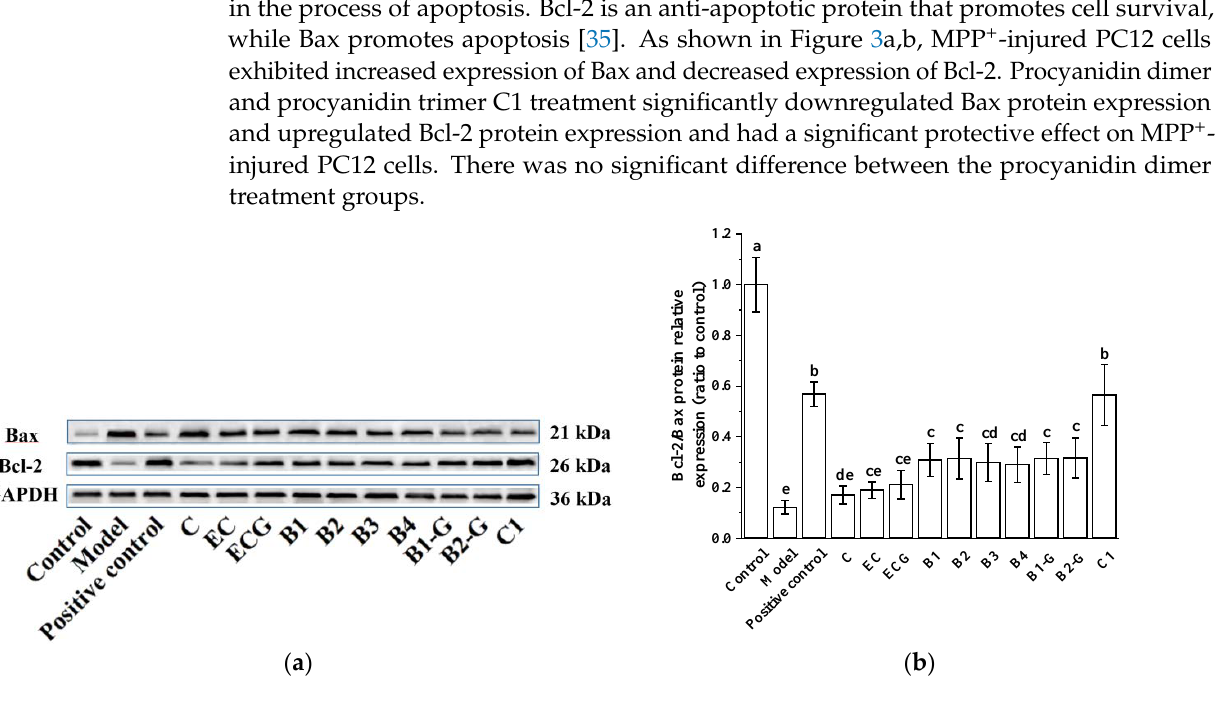
Figure 3 . Effects of different structural procyanidins on the expression of Bax and Bcl-2 proteins in the PC12 cell PD model. ( a ) Protein levels of Bax and Bcl-2, as determined by Western blotting. ( b ) Bcl-2/Bax protein relative expression (ratio to control). Control, Blank control group; Model, MPP +